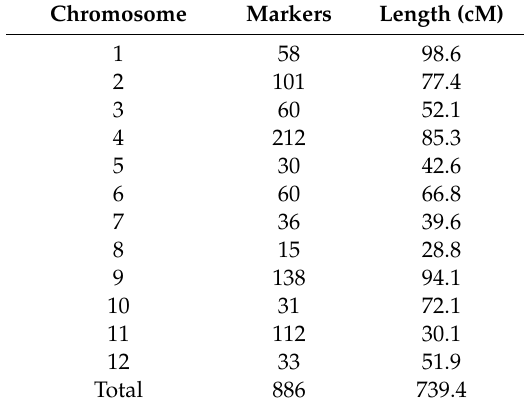
Table 5. Summary of the linkage map of NC 10204 showing 12 chromosomes along with the number of markers per chromosome and the length of each chromosome.